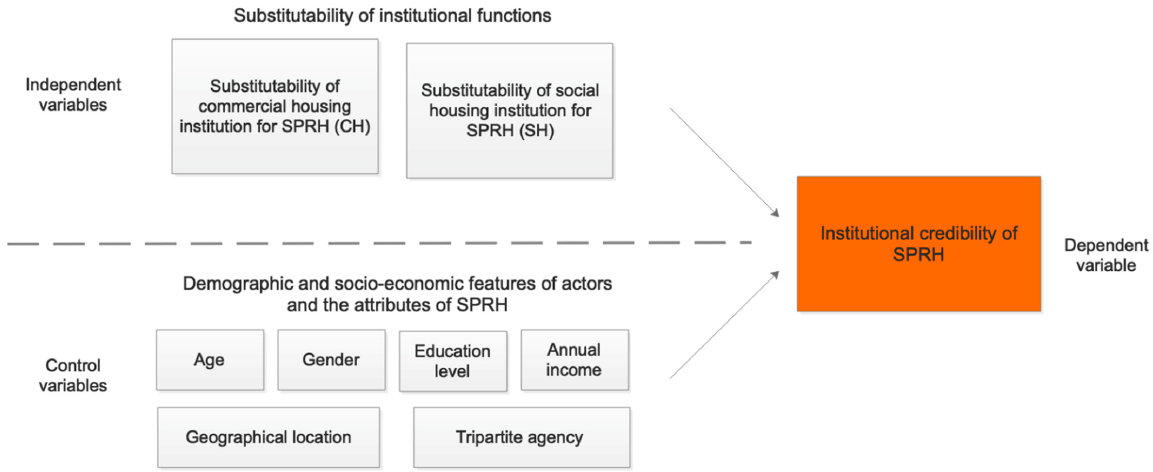
Figure 2. The analytic framework (by the first author).